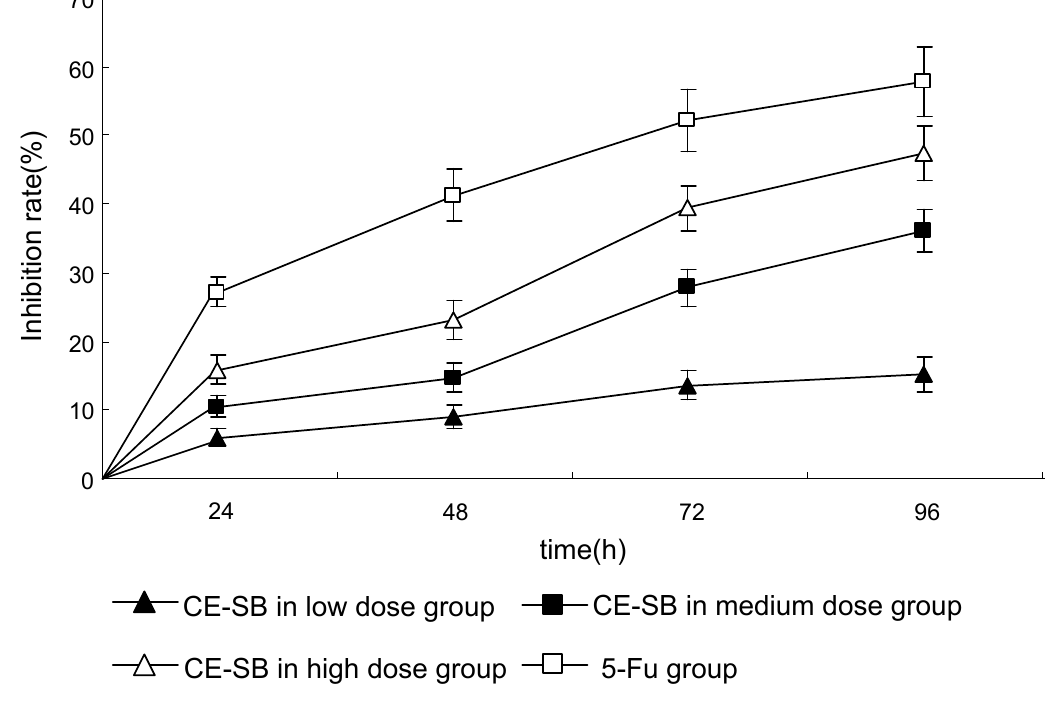
Figure 2. Growth inhibiting effects of CE-SB on hepatoma H22 cells. H22 cells were treated with low-high dose of CE-SB for 96 h. Dose- and time-dependent inhibition of H22 cell growth could be observed ( P < 0.05, ANOVA analysis). Cells were incubated with different dosages of CE-SB and cell proliferation was determined by MTT